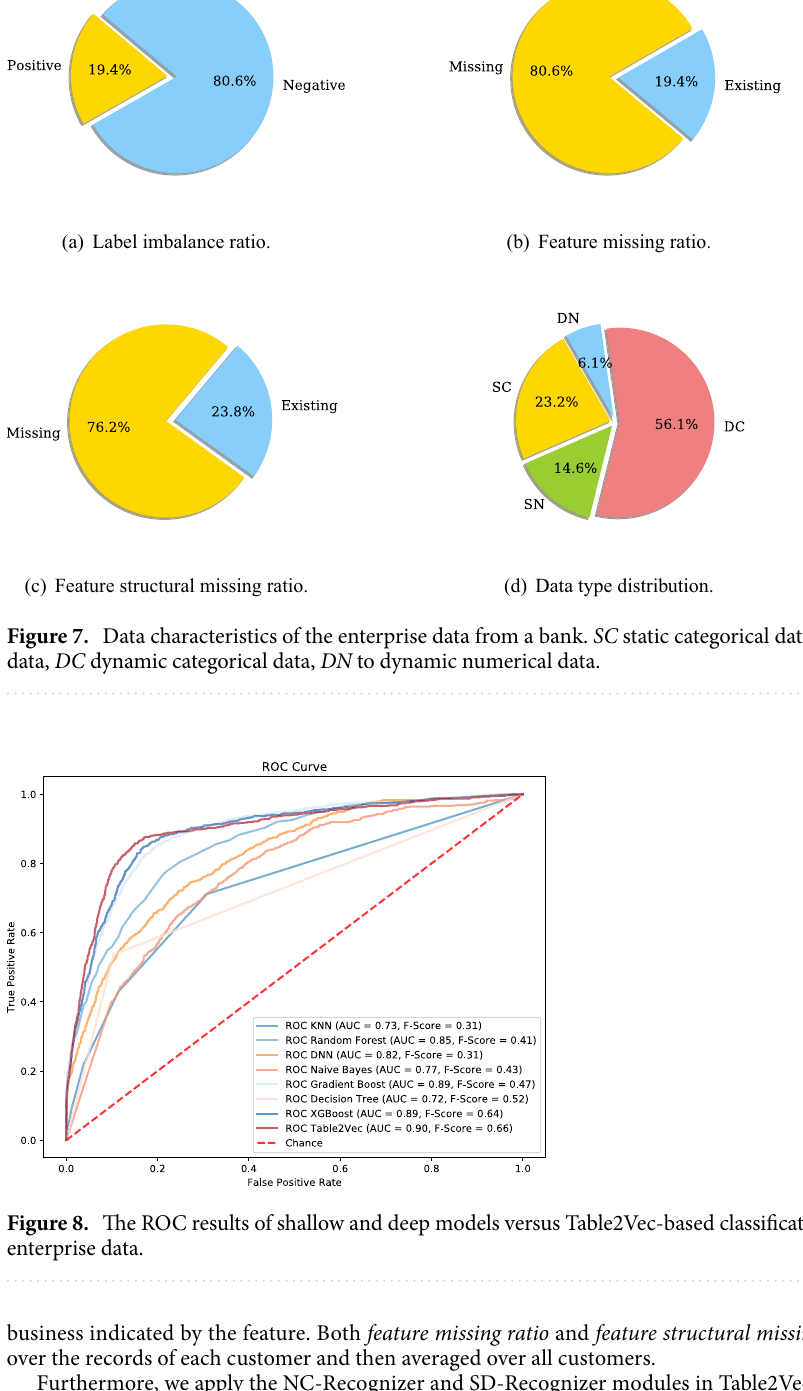
business indicated by the feature. Both feature missing ratio and feature structural missing ratio are calculated over the records of each customer and then averaged over all customers. Furthermore, we apply the NC-Recognizer and SD-Recognizer modules in Table2Vec to automatically dis- tinguish numerical (N), categorical (C), dynamic (D) and static (S) features. We thus obtain four feature com- the sampled big table show that the enterprise big data is dynamic, inconsistent, high-dimensional and sparse, which challenges the in-house enterprise analytics processes and models provided by multinational vendors to this major Australian bank. We evaluate Table2Vec against the baseline models on the banking big table. The results are shown in Fig. 8. Table2Vec outperforms all baselines. Table2Vec achieves the AUC and F-Score on the test data at 0.90 and 0.66, 18.9% in AUC and 18.2% 53% in F-Score over decision tree, random forest, respectively, which gains 4.4% ∼ ∼ KNN, Naive Bayes and DNN. For the two powerful methods XGBoost and GBoost, Table2Vec slightly outper- forms them in terms of AUC but makes a significant improvement in terms of F-Score.